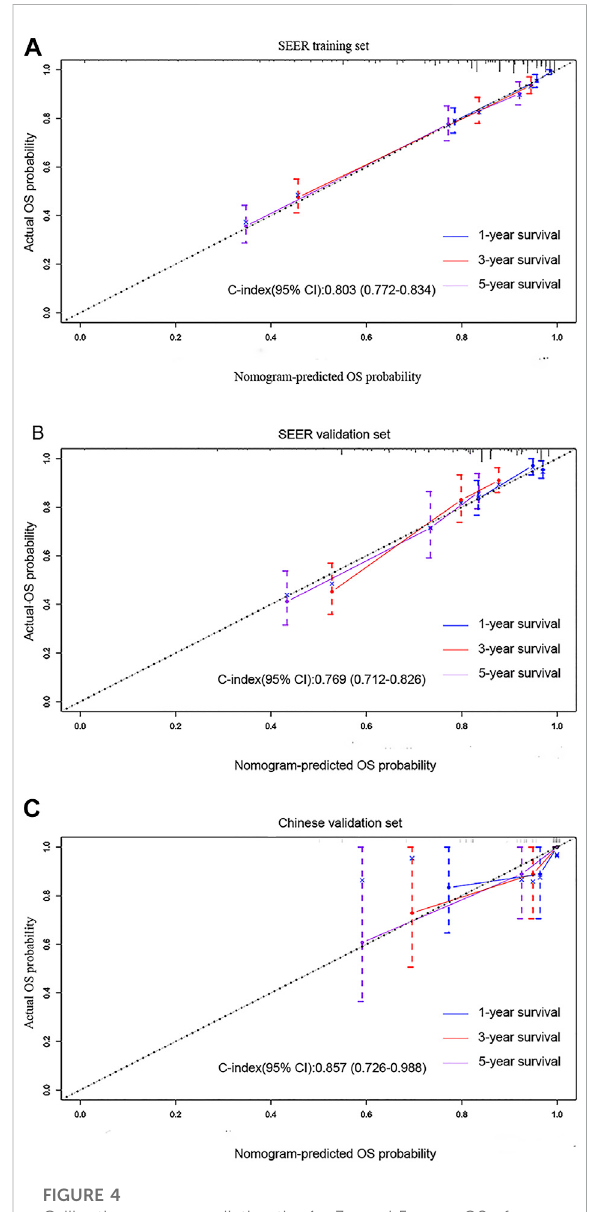
FIGURE 4 Calibration curves predicting the 1-, 3-, and 5-years OS of patients in the (A) training cohort, (B) SEER validation set, and (C) multicenter validation set. The x -axis plots the predicted survival probability, and the y -axis indicates the actual survival probability. The 45-degree inclined curve indicates that the predicted probability is in line with the actual